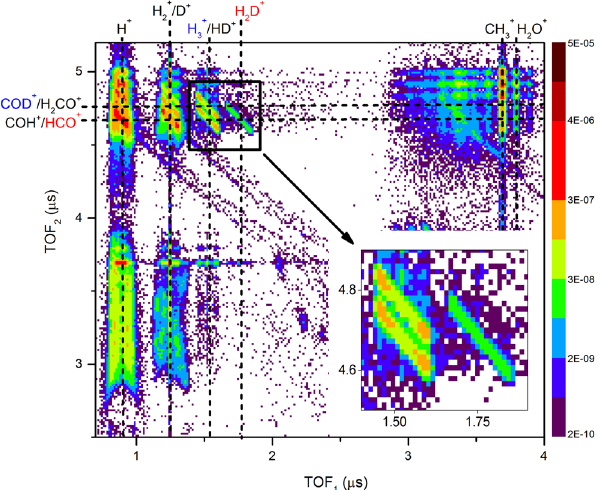
Figure 4. PIPICO map from dissociative ionization of CH 3 OD. On the PIPICO map, the six vertical (dashed) lines represent the approximate center lines of the regions where H + , H 2 + /D + , H 3 + /HD + , H 2 D + , CH 3 + , and H 2 O + ions are recorded. The top horizontal (dashed) line indicates the COD + /H 2 CO + ion region and the bottom horizontal line indicates the COH + /HCO + ion region. The contour region with an approximate slope of − 1 at the intersection of the vertical H 2 D + line and the horizontal COH + /HCO + line represents the coincidence channel of H 2 D + + HCO + (red colored label) while the contour region at the intersection of the vertical H 3 + /HD + line and the horizontal COD + /H 2 CO + line represents the coincidence channel of H 3 + + COD + (blue colored label). The coincidence channel of H 3 + + COH + /HCO + due to CH 3 OH contamination is visible as the contour region at the intersection of the vertical H 3 + /HD + line and the horizontal COH + /HCO + line. A magnified view of these three channels is given in the inset. The logarithmic color scale depicts the event rate in units of